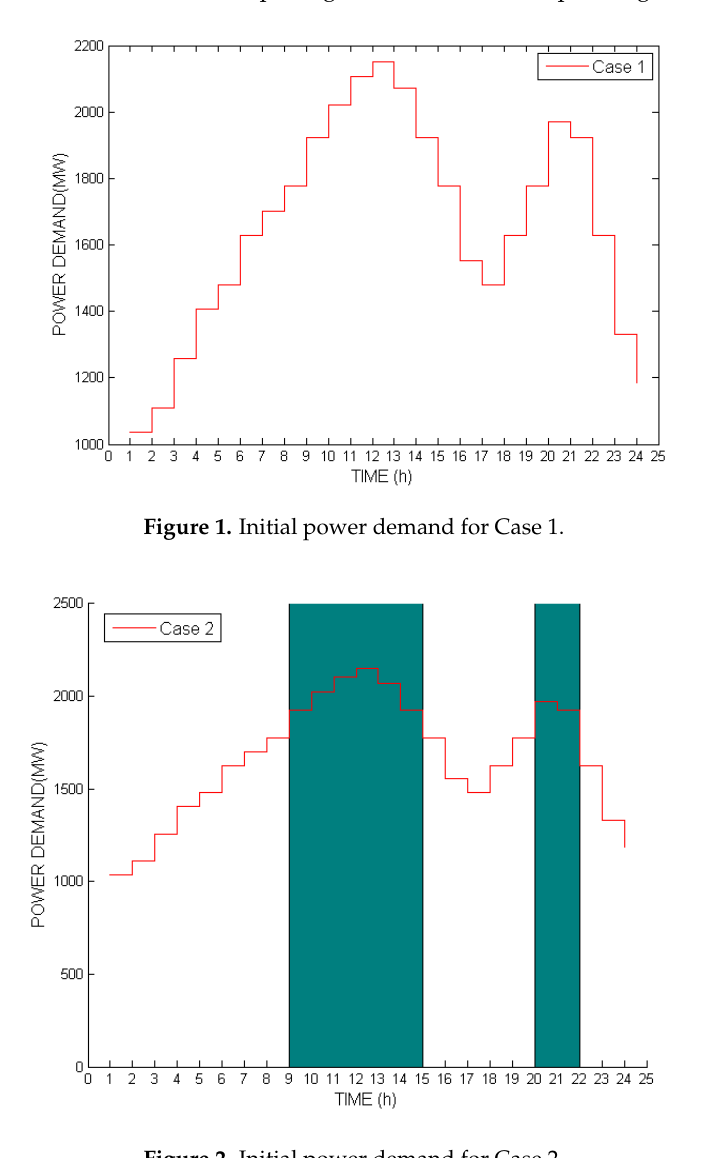
Figure 2. Initial power demand for Case